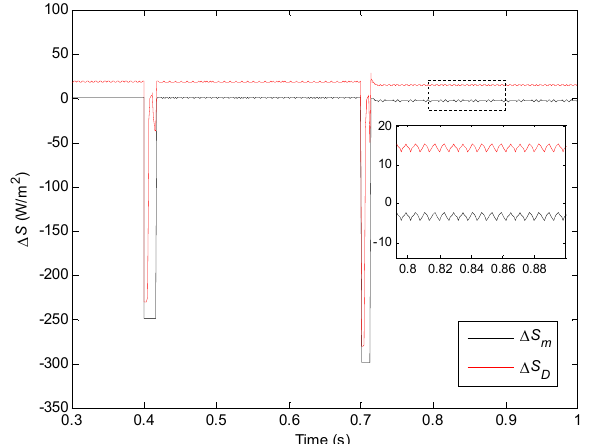
Figure 15. S curve in first simulation. D